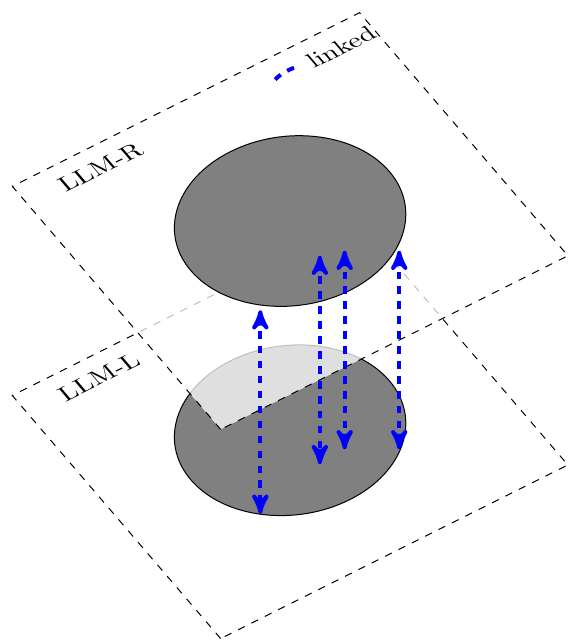
Figure 16 . Schematic representation of the gravity dual for two maximally entangled superstars. The existence of quantum correlations and entanglement is simulated by linking both LLM geome- tries along the droplets.